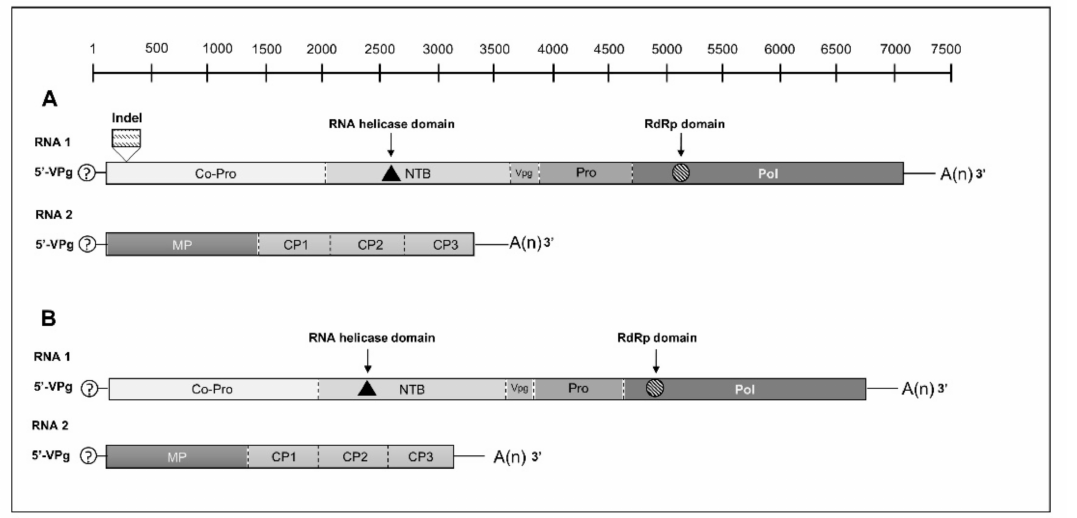
Figure 1. Hypothetical genome organization of alpine wild prunus virus- P. brigantina (AWPV-Pb) ( A ) and of stocky prune virus (StPV) ( B ). Putative cleavage sites of RNA1 and 2 deduced polyproteins are represented by dashed lines. The conserved motifs of helicase and RNA-dependent RNA polymerase (RdRp) are shown by black triangle and hatched circle, respectively. The position of the indel of 138 nt in AWPV-Pb RNA1 in comparison to AWPV-Pm RNA1 is shown. Co-Pro: protease cofactor; NTB: nucleotide triphosphate binding helicase; VPg: viral genome-linked protein; Pro: protease; Pol: polymerase; MP: movement protein; CP: coat protein. RdRp: RNA-dependent RNA polymerase. The RNA1 5 (cid:48) noncoding regions (NCRs) are 50 nt long in AWPV-Pb and AWPV-Pm, and 80 nt long in StPV (Table 3). The 3 (cid:48) NCRs are longer, comprising between 229 nt (AWPV-Pm) and 251 nt (StPV) (Table 3). In RNA2, the 5 (cid:48) NCRs are 69, 70 and 78 nt long, and the 3 (cid:48) NCRs comprise between 241 nt (AWPV-Pb) and 251 nt (AWPV-Pm) (Table